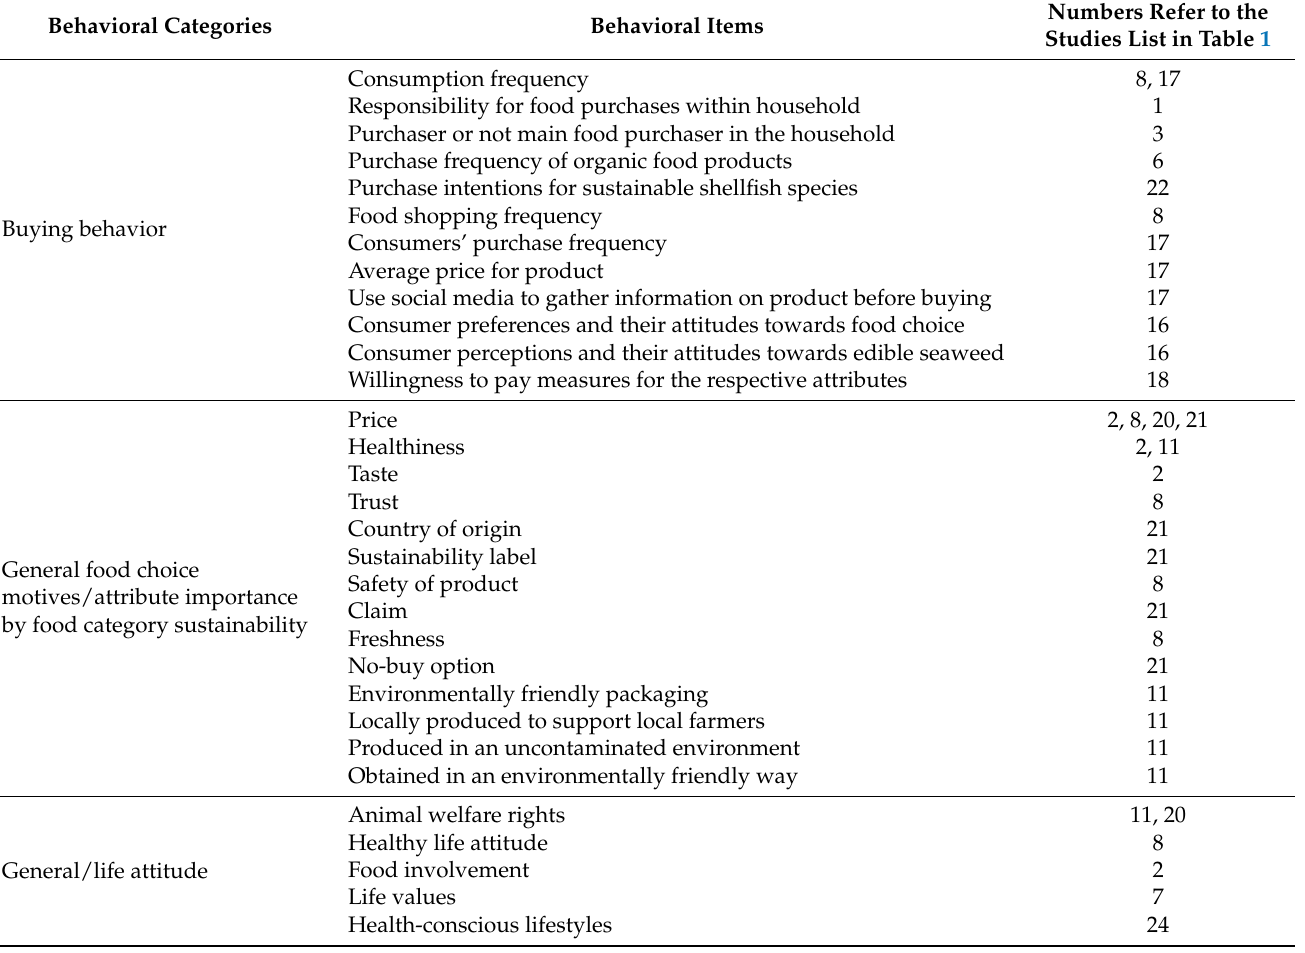
Table 4. Behavioral factors used in the analyzed